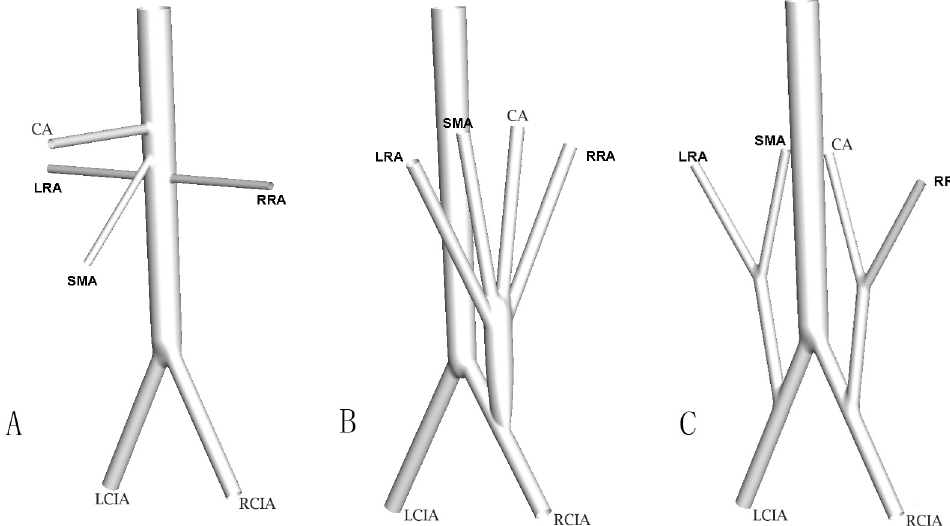
Fig 2. Sketches of model geometry. A) Structure of normal AA; B) RVR using unilateral quar-furcated graft; C) RVR using bilateral bi-furcated grafts. CA-celiac artery, LRA-left renal artery, RRA-right renal artery, SMA- superior mesenteric artery, LCIA-left common iliac artery, RCIA-right common iliac artery.